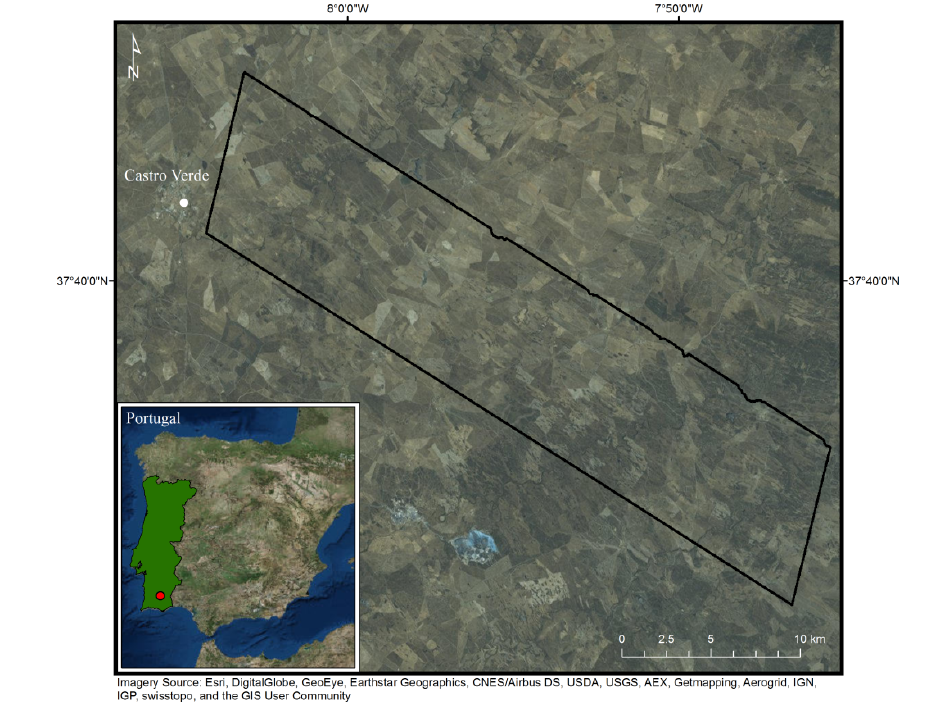
Figure 2. Study area in the Castro Verde region in Southern Portugal, characterized by agricultural land abandonment (NW–SE gradient) leading to successional shrub